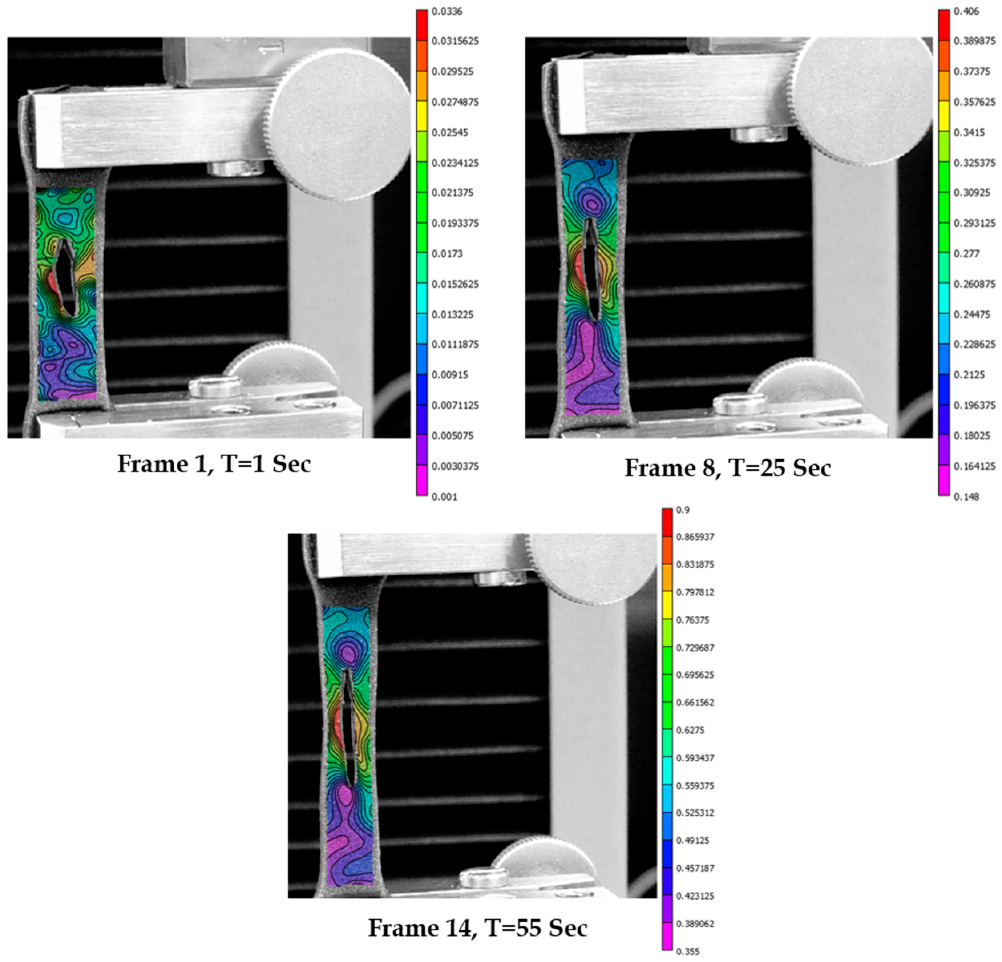
Figure 8. Strain distribution at different times for symmetric ‐ short wound 1 measured using DIC.